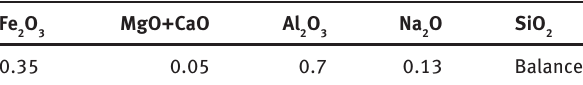
used as reinforcement 2